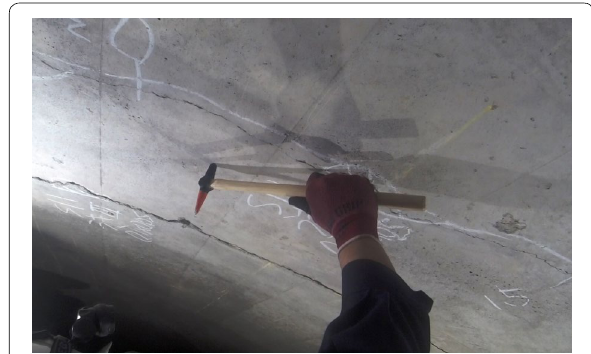
Fig. 1 Hammering test conducted by a professional on the ceil- ing portion of a tunnel: only a simple hammer is needed thus the popularity of this non-destructive testing method. Still, there is the need of skilled operators to correctly differentiate hammering sounds and given the great population of structures in need of testing, automation is actively demanded. Also, since it relies heavily on the operator’s skills, the final result remains